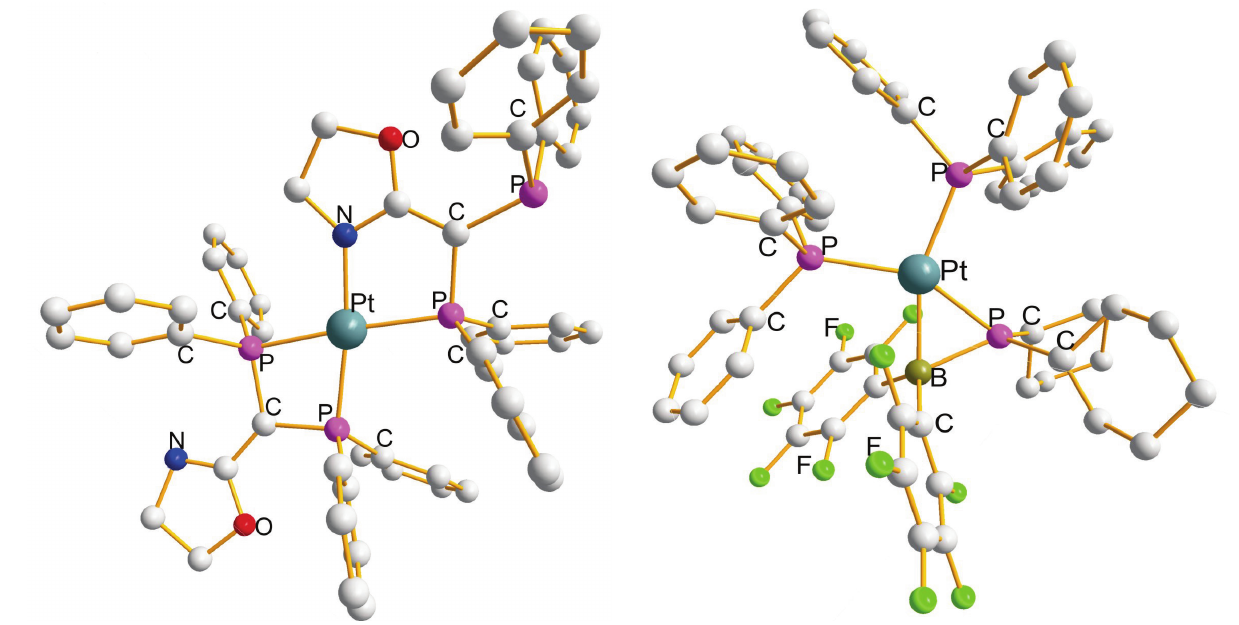
P(C H NO)PPh 2 4 4